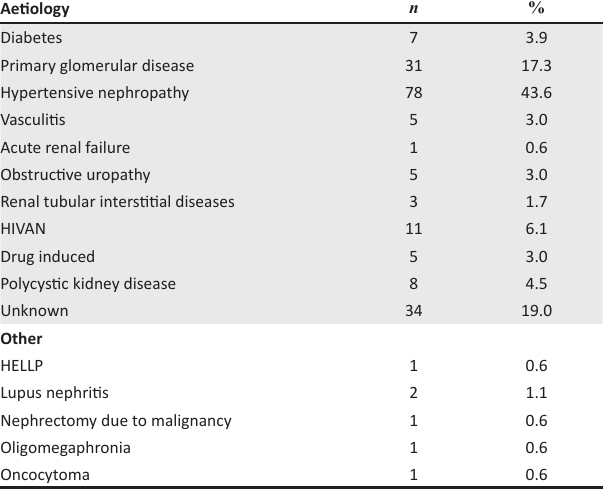
TABLE 1: Aetiology per patients ( n =